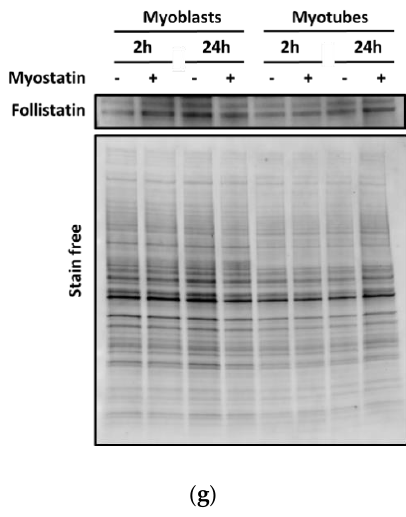
Figure 9. Differentiation of the CHQ cells did not alter the mRNA level of ( a ) follistatin, ( b ) ACVR2B and ( c ) GDF11. Of the ACVR2 ligands, the mRNA of ( d ) activin A and ( e ) myostatin were decreased in CHQ myotubes in comparison to myoblasts. ( f ) Differentiation of CHQ myoblasts into myotubes had no effect on follistatin protein content. ( g ) Representative blot. In the figures, the values are presented as normalized to myoblasts = 1. In A – E, N = 4 – 5 per group. In F, N = 12 per group as control (-) and myostatin (+) samples were pooled due to the lack of myostatin effect. ** = P < 0.01.